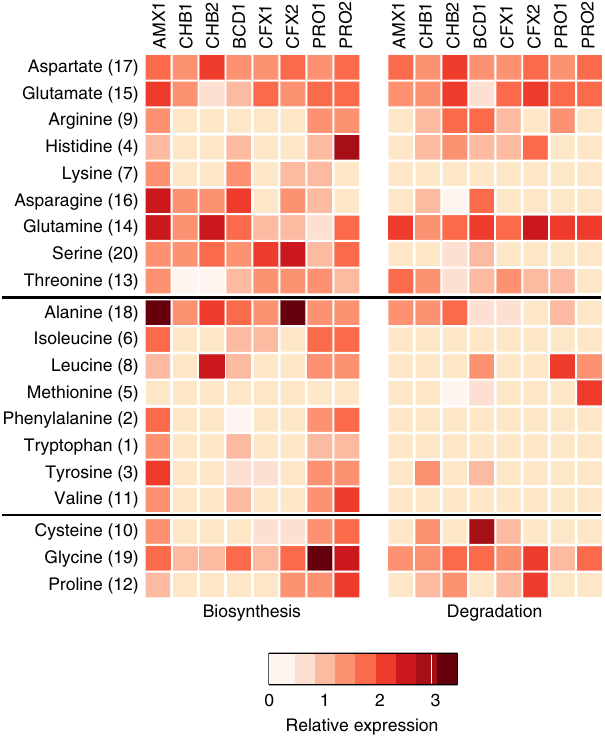
Figure 6 | Relative gene expression of amino acid biosynthetic and degradation pathways encoded by each MAG. Red colour intensity represents gene expression, which was relativized by median RPKM values calculated across each ORF in a given MAG. A value of 1 equals median expression. Top, middle and bottom panels separate amino acids by hydrophilic, hydrophobic and special structured side chains, respectively. Bracketed numbers rank the metabolic cost of amino acid biosynthesis based on values reported by Akashi and Gojobori 38 , with 1 being the most